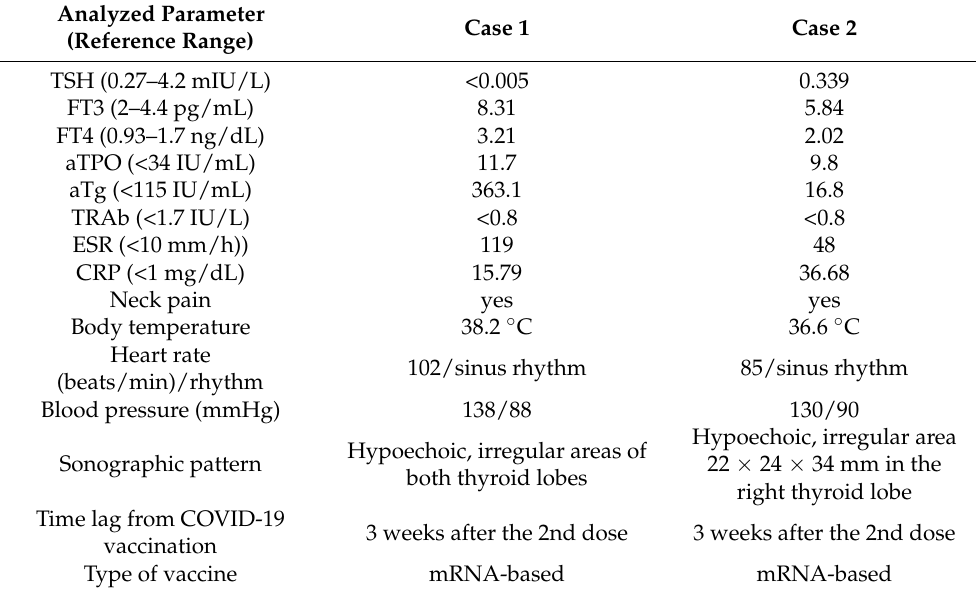
Table 1. The most important results of the patients’ laboratory tests and clinical findings at the time of SAT